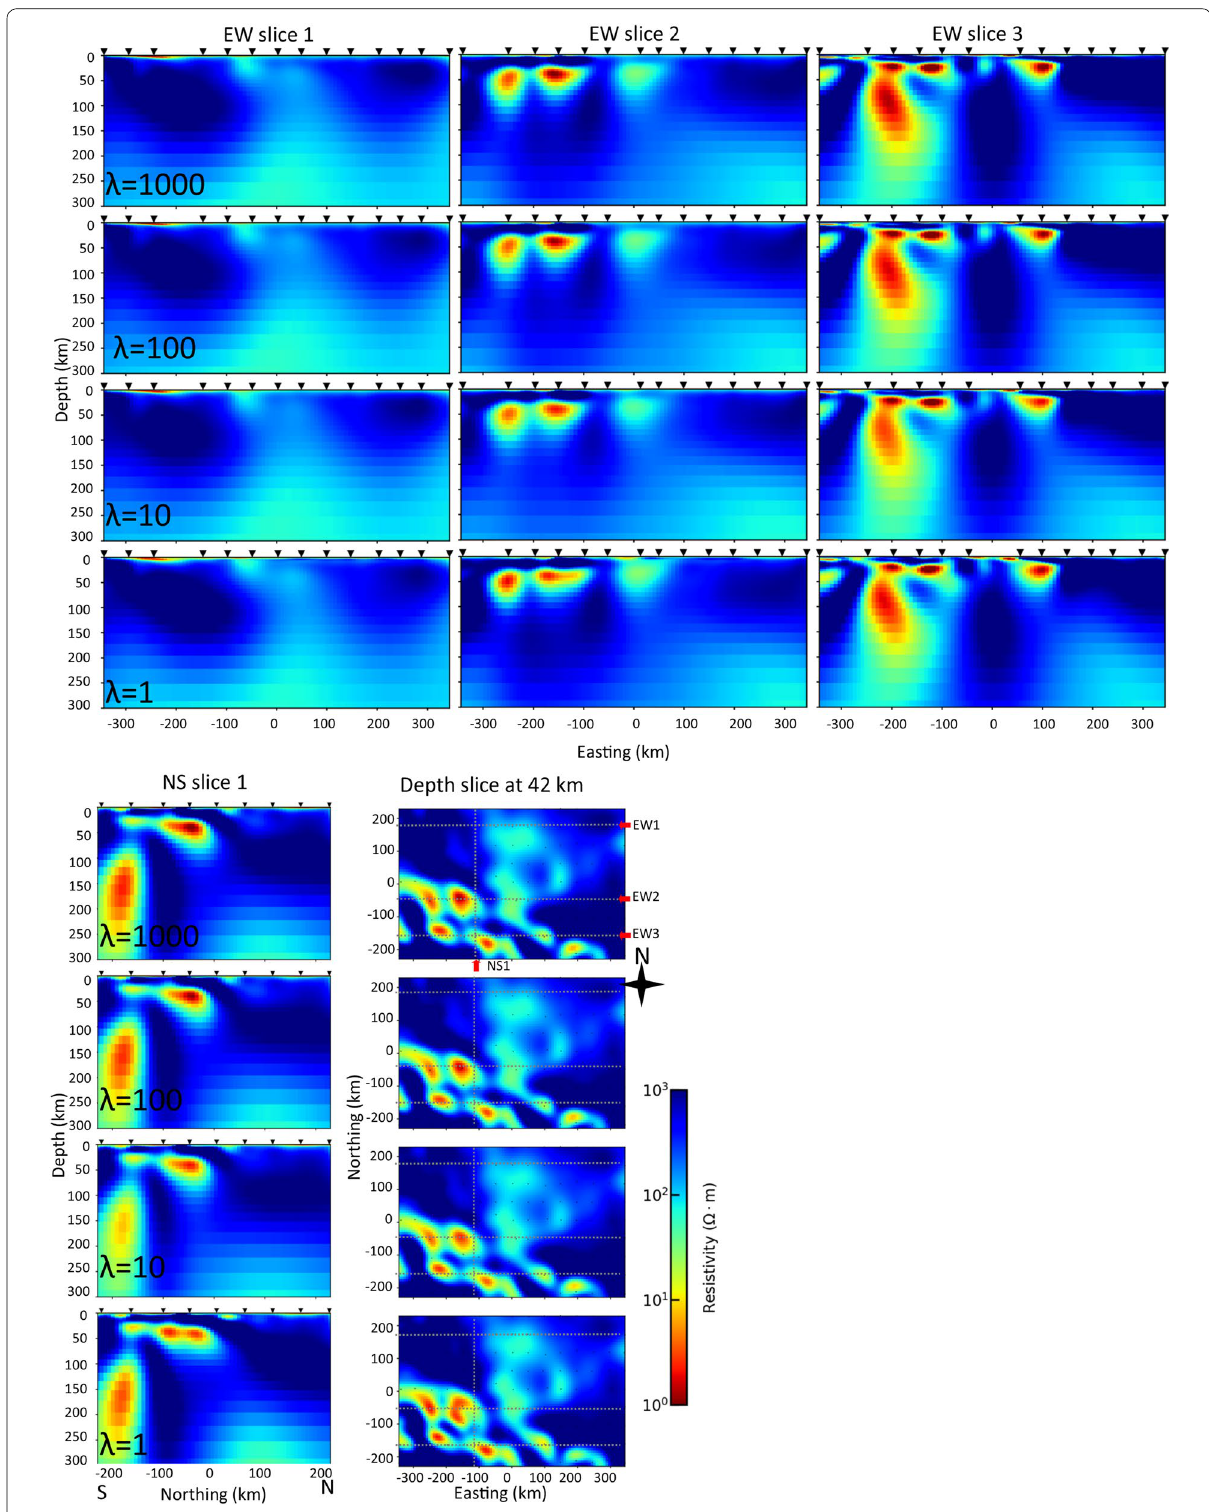
Fig. 3 Three east–west cross sections (top row), a north–south cross section (bottom left) and a depth slice at 42 km (bottom right) through the models where all model setup and parameters were identical except (cid:31) 1000, 100, 10 and 1 from top to bottom. The locations that the cross = sections are extracted from are shown as grey dashed lines in the bottom right